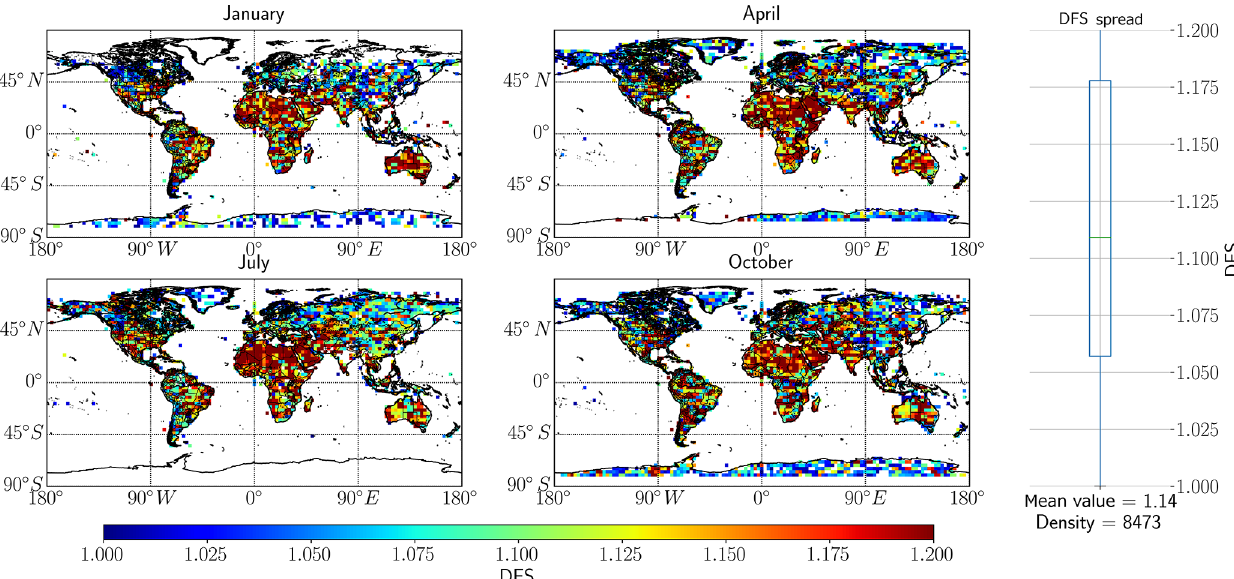
Figure 3. Global spread of DFS based on the RemoTeC synthetic data ensemble, with 13 CH 4 as the target for retrievals. The four main seasons in the synthetic database are represented in this figure by 1d in the months of January, April, July and October. The far right panel in the figure outlines the spread of DFS values over the entire dataset in the form of a boxplot indicating median and upper and lower quartile values, with the mean value and the total number of measurements indicated at the bottom; the circles are outlier values.